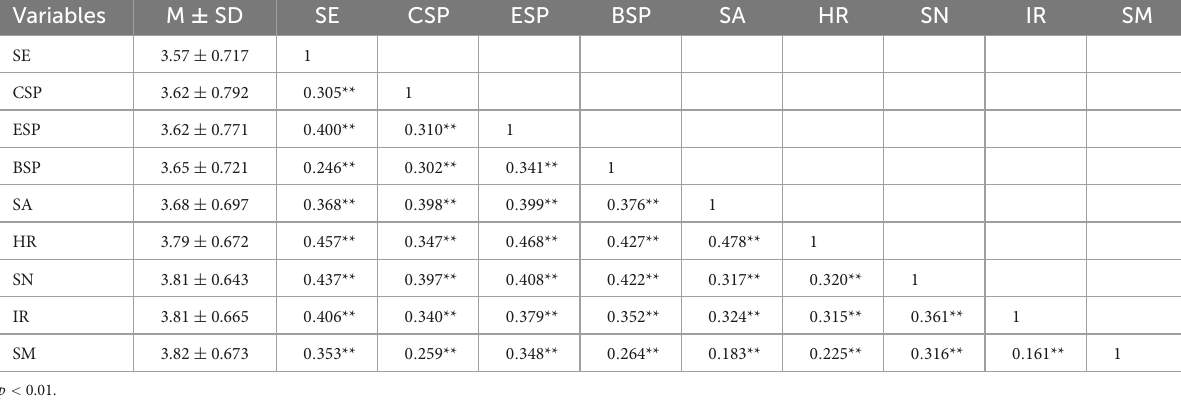
TABLE 4 Correlation results.